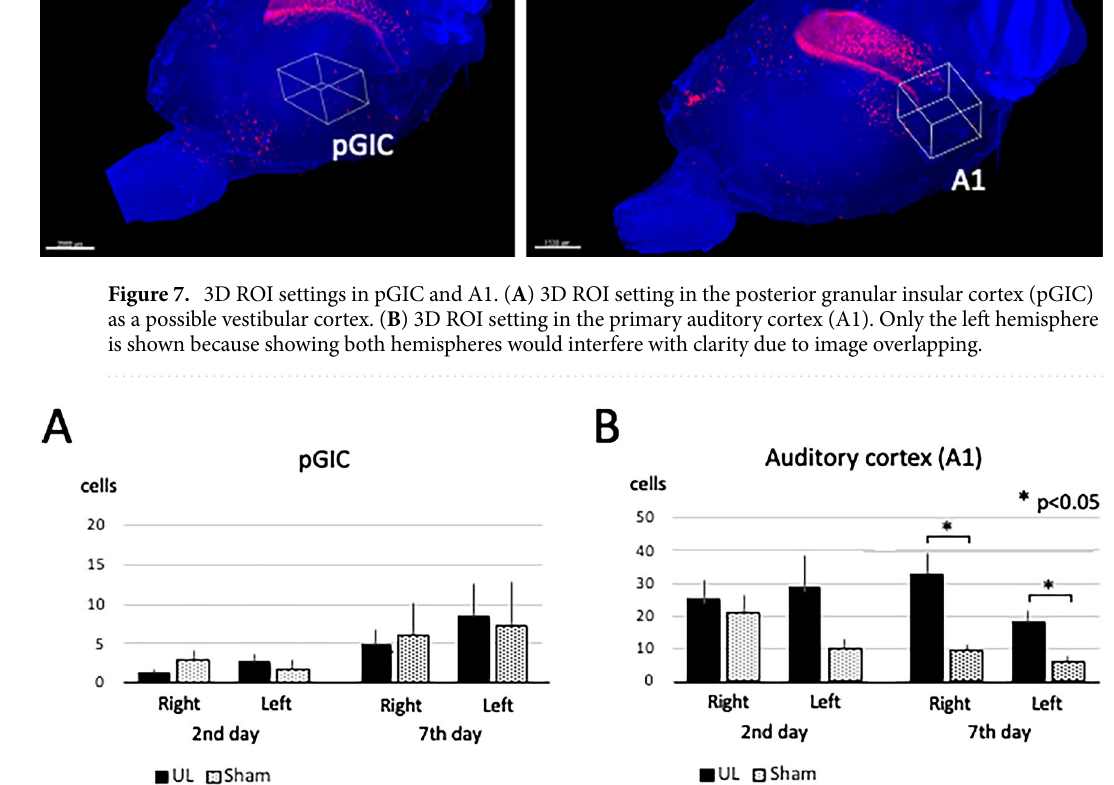
Figure 8. Activated neurons in pGIC and A1. ( A ) Activated neurons in the the posterior granular insular cortex (pGIC). No significant differences were observed between the UL and the sham-treated group. ( B ) Activated neurons in the auditory cortex (A1). There were no significant differences in A1 between the UL and the sham-treated group on day 2 after surgery; however, there were significantly more activated neurons in A1 of the UL group than in the sham-treated group on day 7 after surgery. Error bars indicate the standard error of the